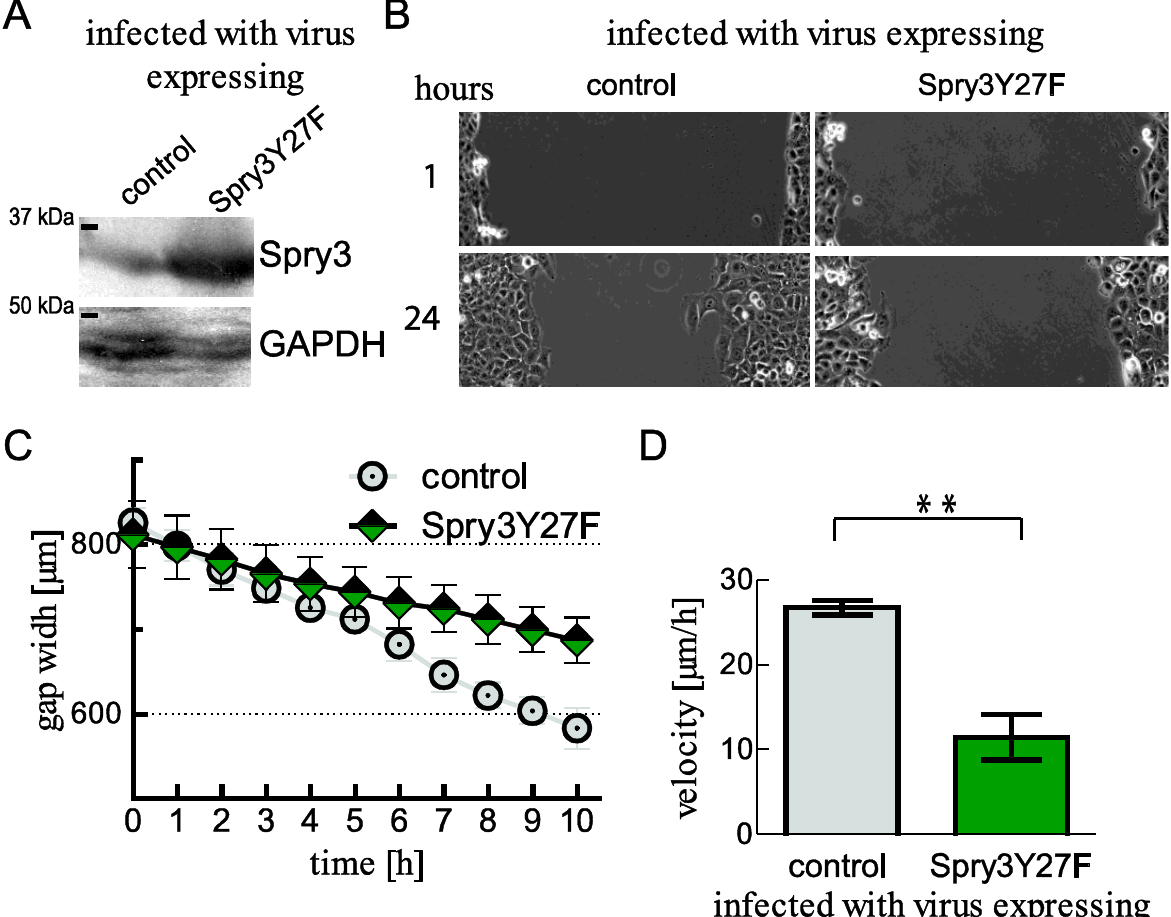
Figure 7. Influence of the mutated Spry3Y27F protein on cell migration. ( A ) U2OS cells were infected with adenoviruses expressing either a control or the mutated Spry3Y27F protein and expression of the introduced Spry3Y27F protein was proved by an immunoblot using antibodies recognizing Spry3. ( B ) A scratch assay with the cells expressing the indicated proteins was performed. Pictures of a representative scratch showing the gap at 1 and 24 h are shown. The loading was controlled by detecting GAPDH. ( C ) The distance coverage of three replicates of a representative scratch is depicted over the first 10 h. ( D ) By performing linear regression of the gap closure, the velocity was determined and the graph summarizes three experiments. Means ± SEM are shown. ** p < 0.01 .